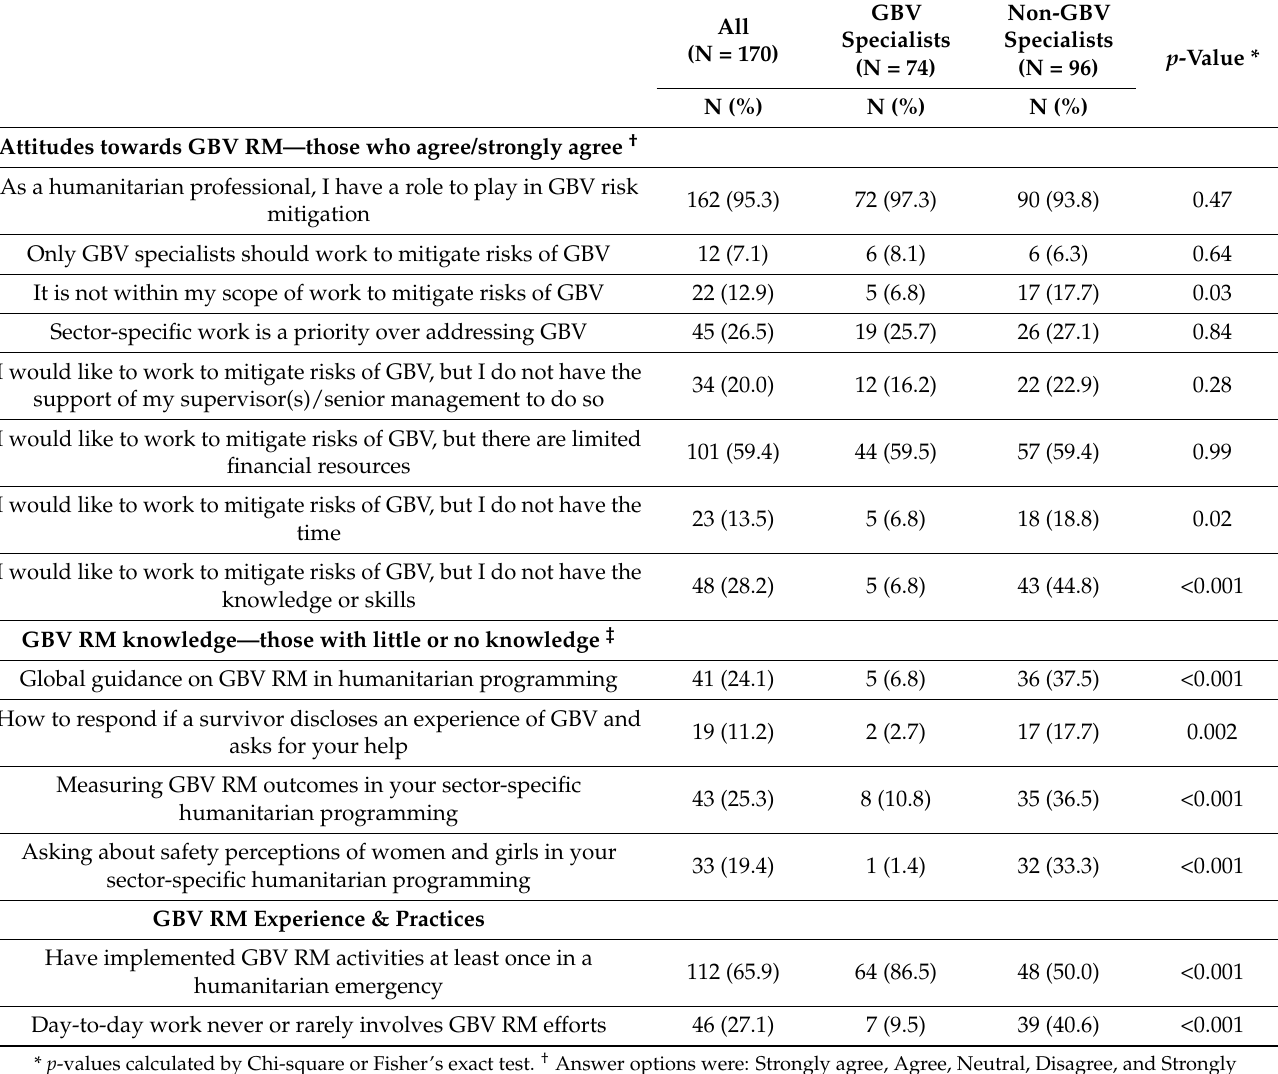
Table 3. GBV Risk Mitigation Knowledge, Attitudes and Practices of GBV and non-GBV specialists.